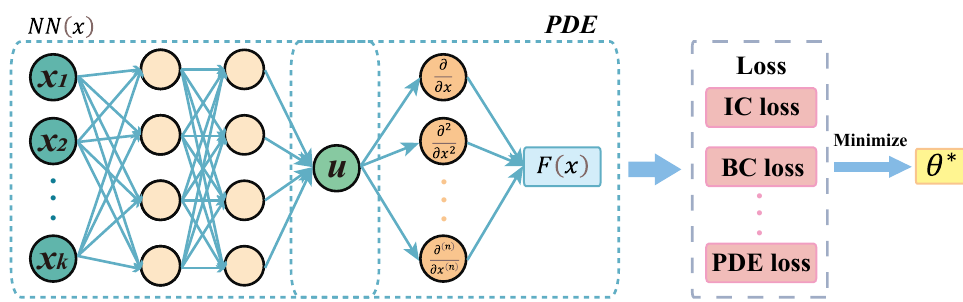
Figure 2. The principle of the PINN